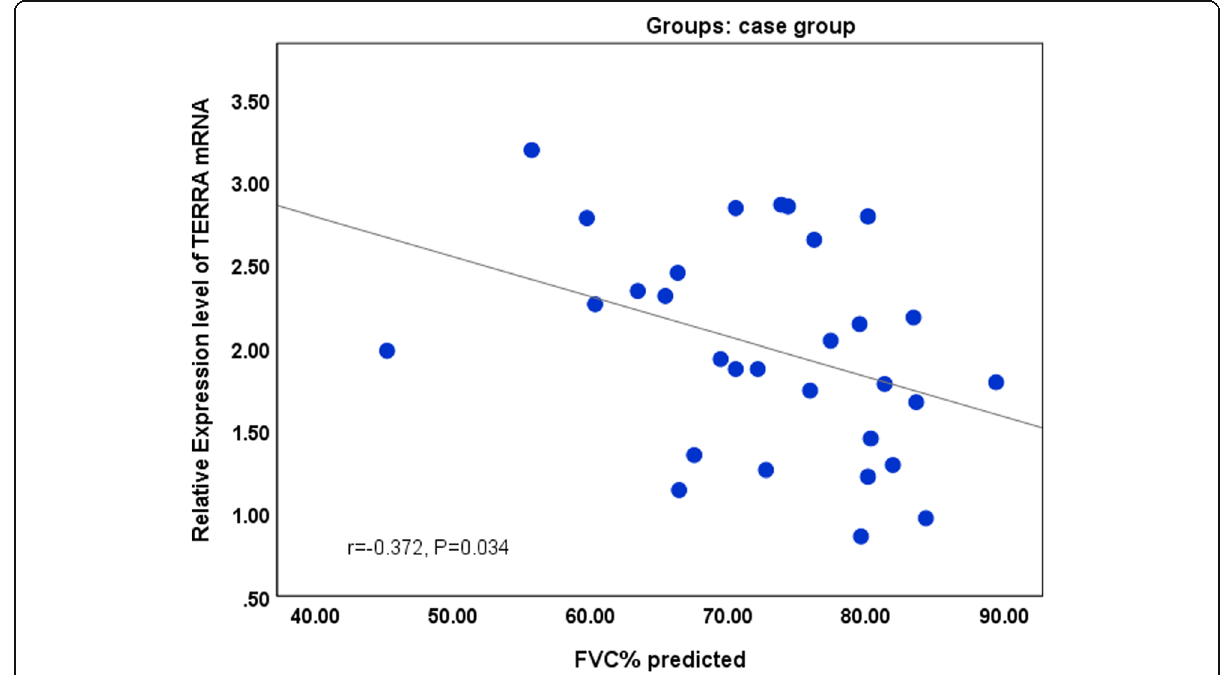
Fig. 5 Scatter diagram showing that both relative expression and duration of symptoms have a positive